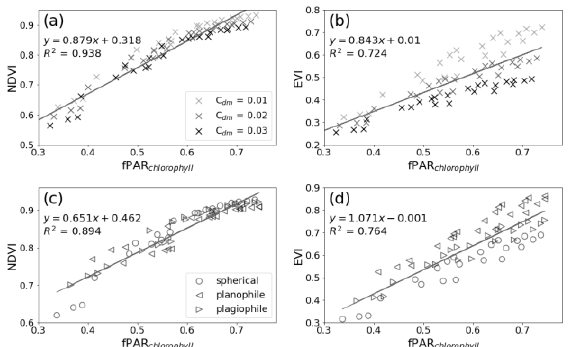
Figure 1. Simulated relationship between fPAR chlorophyll and VIs using inputs described in Table S1 (a and b for Case 1 and c and d for Case 2). PAR absorbed by chlorophyll was used to calculate fPAR chlorophyll .